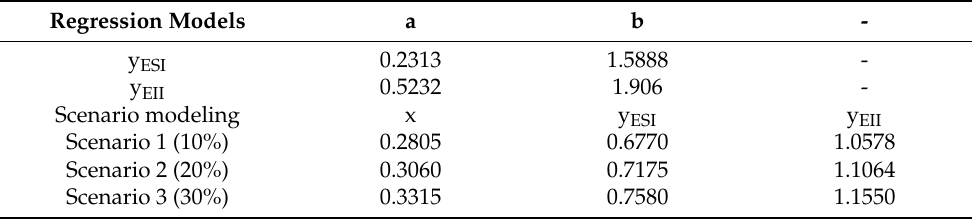
Table 8. Modeling according to scenarios of electricity generation by households in the studied countries.